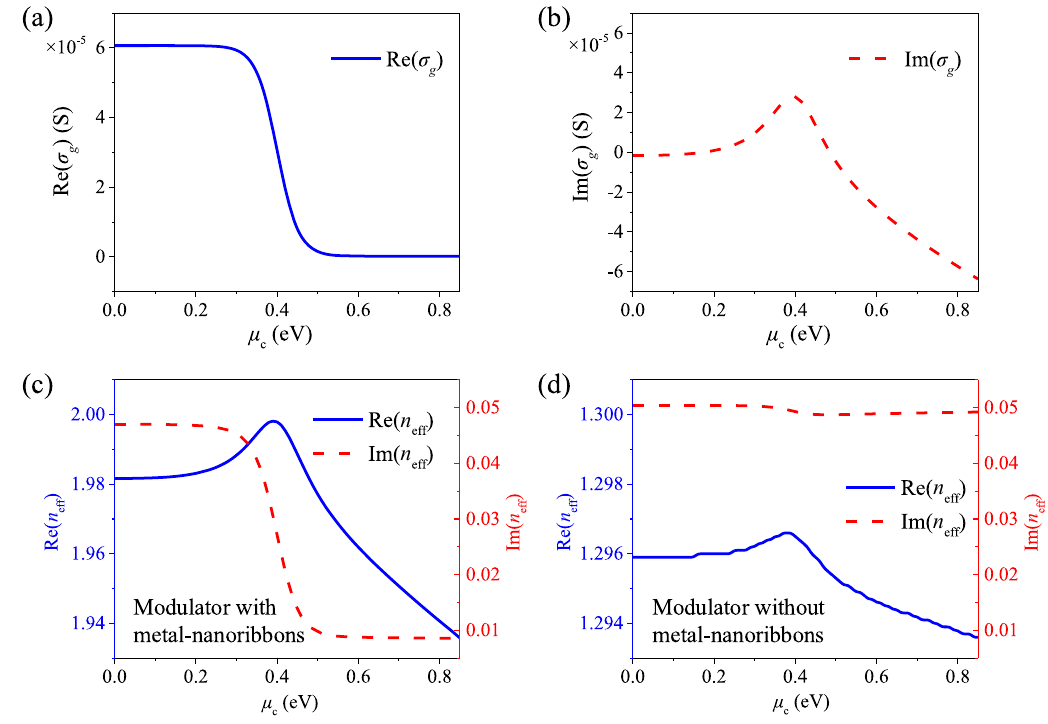
Figure 2: Calculated graphene surface conductivity Re( σ g ) (a) and Im( σ g ) (b) as a function of the graphene chemical potential μ c . Simulated Re( n eff ) and Im( n eff ) as a function of graphene chemical potential μ c for the proposed GPM with metal – nanoribbons (c) and without metal – nanoribbons